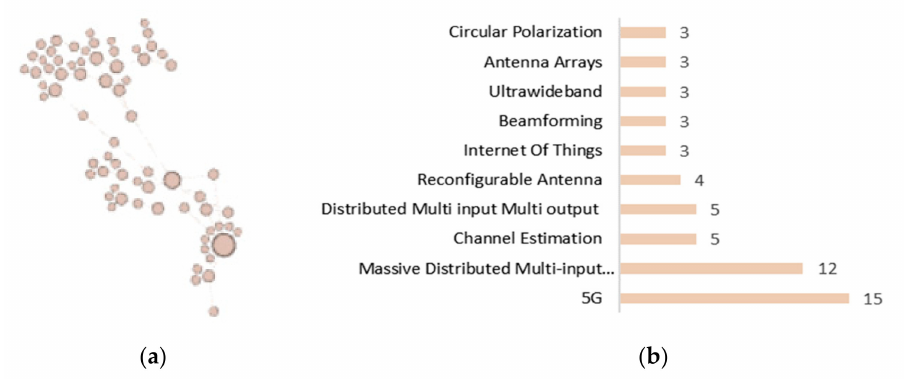
Figure 15. Representation of the Wireless Communications community: ( a ) Isolated distribution of publications. ( b ) Keywords of the